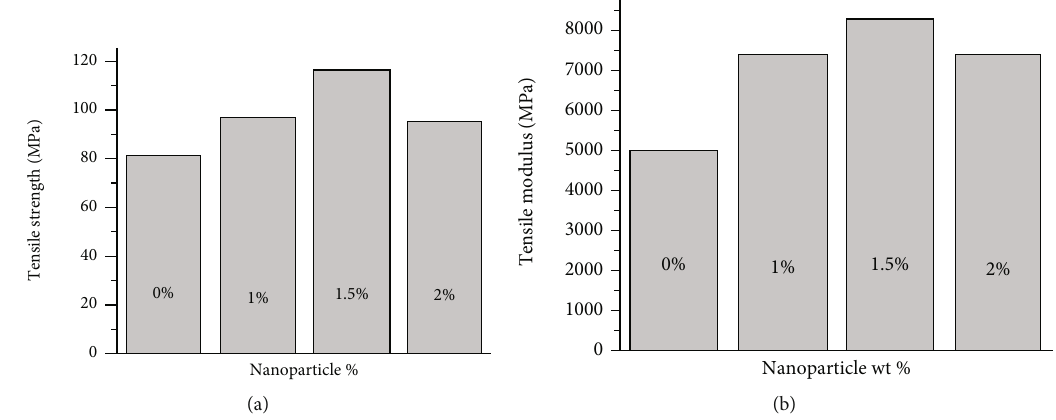
Figure 5: Mechanical properties of the nanocomposite: (a) tensile strength and (b) tensile Table 2: Flexural property of nanocomposites. Nanoparticle content in epoxy glass fi ber reinforced composite (wt.%)